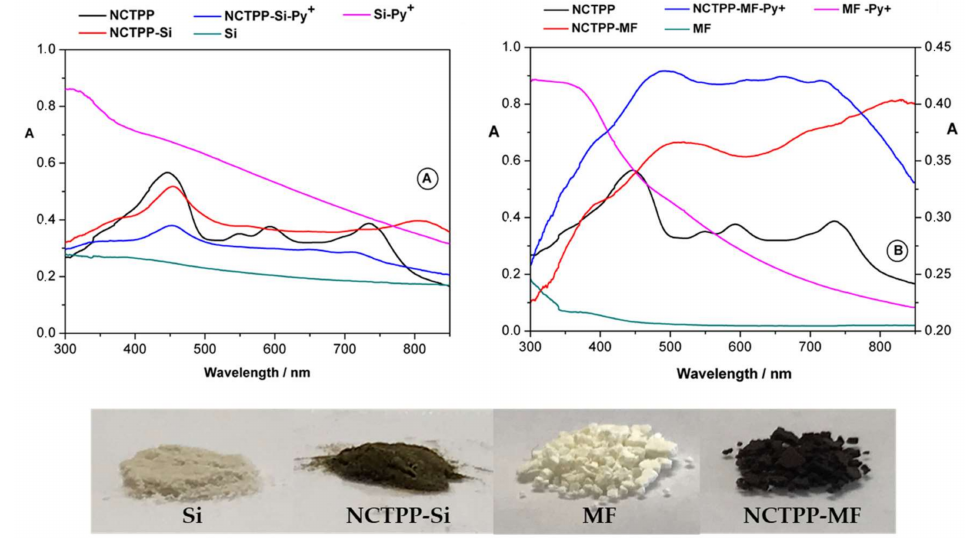
Figure 2. Top: Solid state UV-Vis spectra of ( A ) NCTPP, Si, and organic/inorganic-hybrids and ( B ) NCTPP, MF, and organic/inorganic hybrids. Bottom: visual appearance of Si and MF materials before and after NCTPP